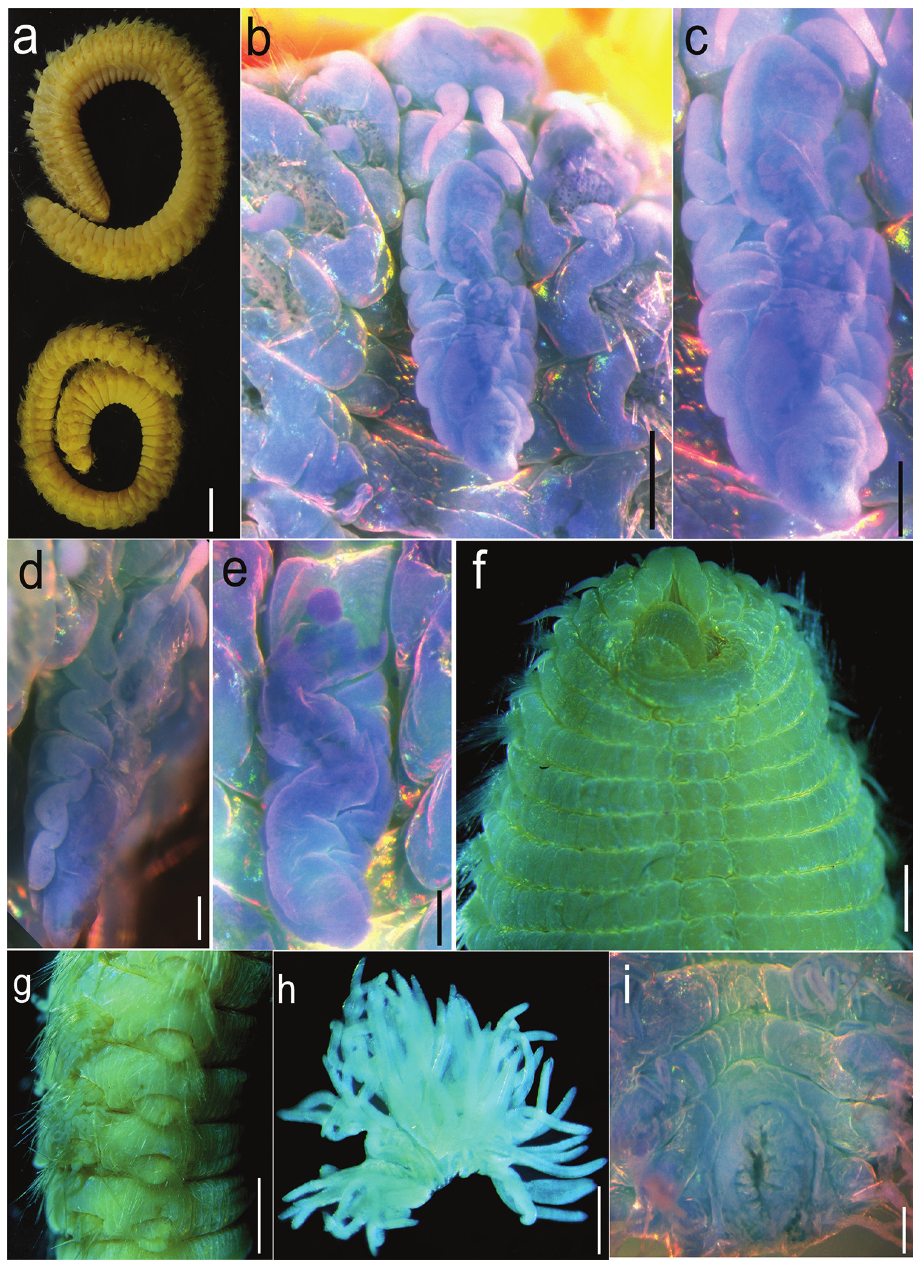
Figure 1. Alleurythoe tenuichaeta gen. n. & sp. n., a Entire animal in lateral view b Prostomium and caruncle, dorsal view c Caruncle, dorsal view d Caruncle, lateral view. Caruncle, dorsal view f Anterior chaetigers, ventral view g Parapodia of middle chaetigers, lateral view h Branchia of posterior chaetiger i pygidium, dorsal view. a–d, f–i holotype e paratype. Scale bars a 0.5 cm; b 0.5mm, c 0.25 mm; d–e, i 0.2 mm; f 1 mm; g 2 mm; h 0.5